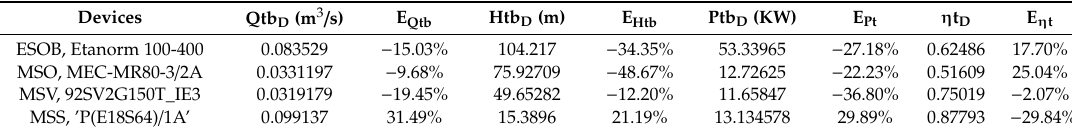
Table 6. PAT performance at BEP, evaluated using Derakhshan and Nourbakhsh